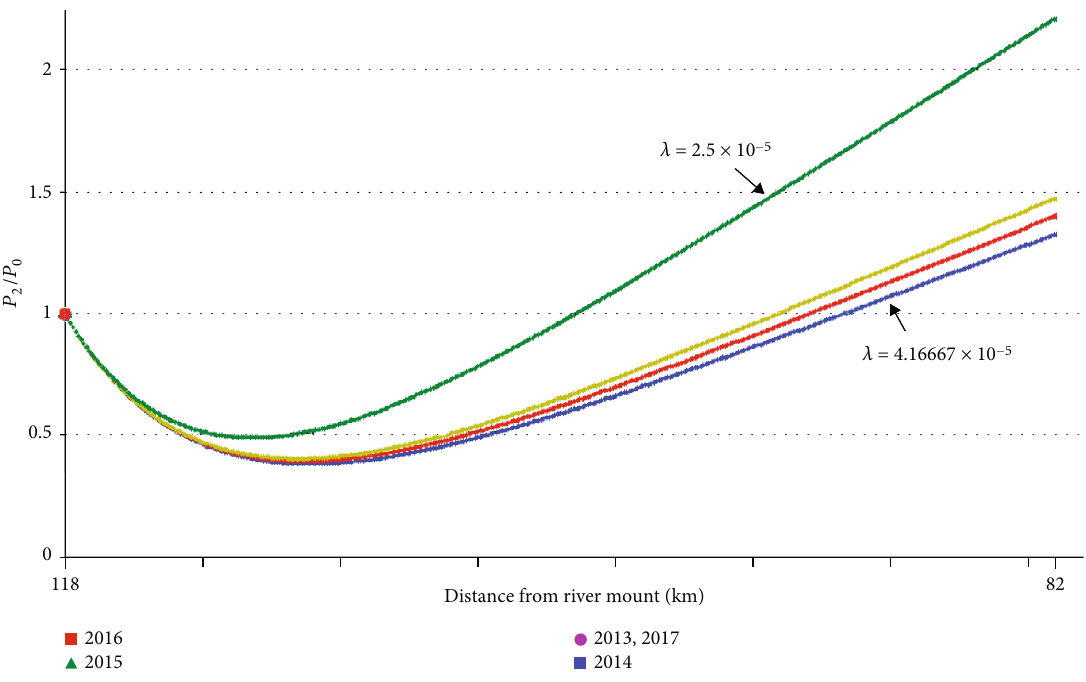
Figure 6: Behaviors of pollutant concentration ( P